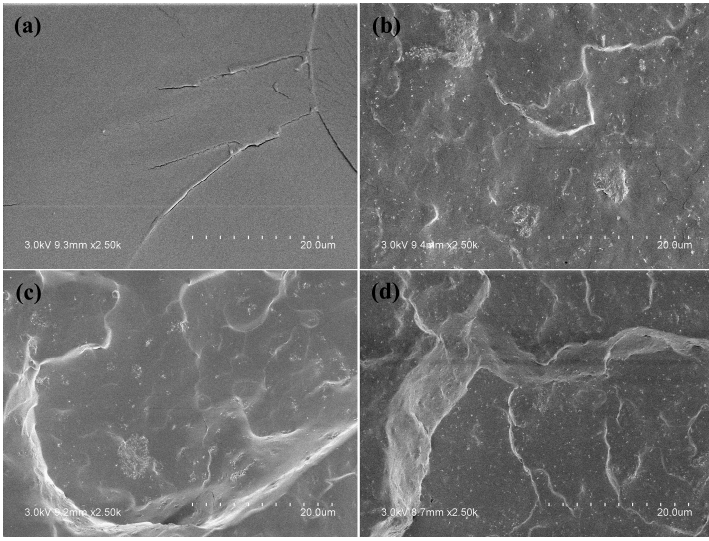
Figure 5. SEM images of neat PU and PU nanocomposites: neat PU ( a ), PU/ATT8 ( b ), PU/acid-ATT8 ( c ) and PU/KH560-ATT ( d ).